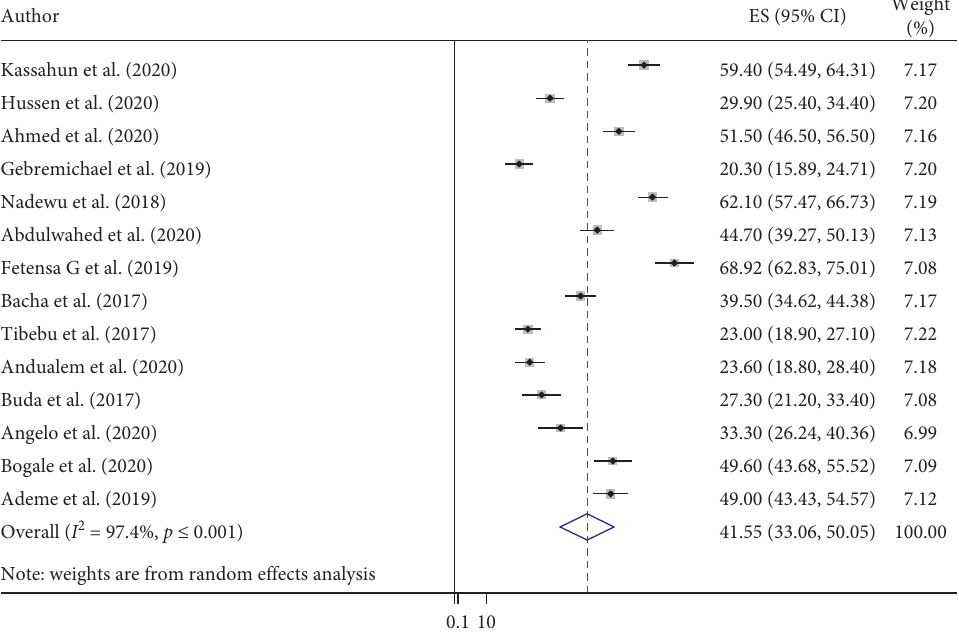
Figure 2: Forest plot of included studies that assess the level of self-care practice among hypertensive patients in Ethiopia. Table 2: Subgroup analysis of the estimated pooled level of self-care practice among hypertensive patients in Ethiopia. Variable